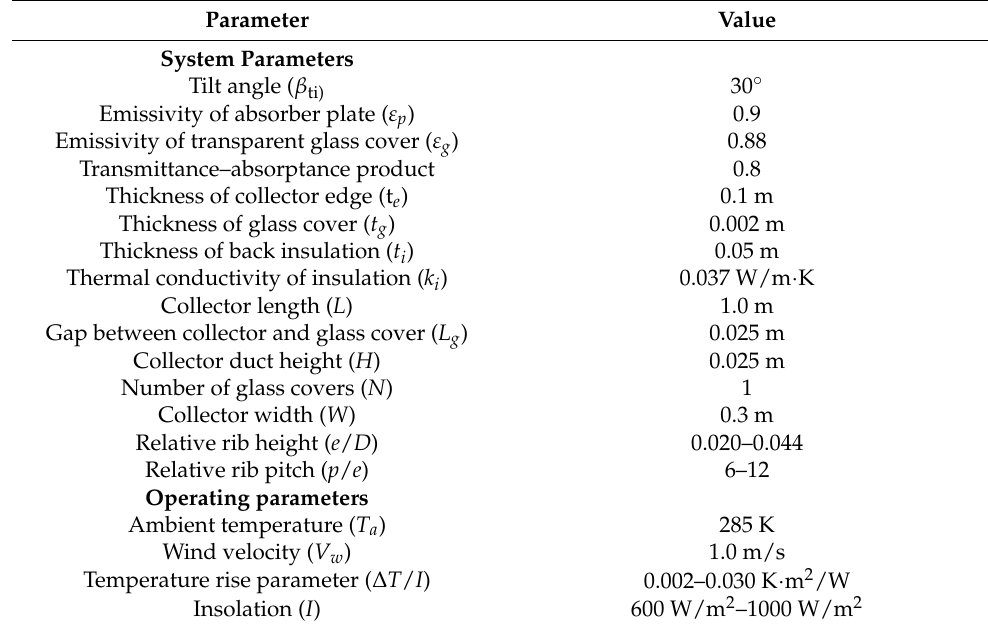
Table 1. Values/ranges of